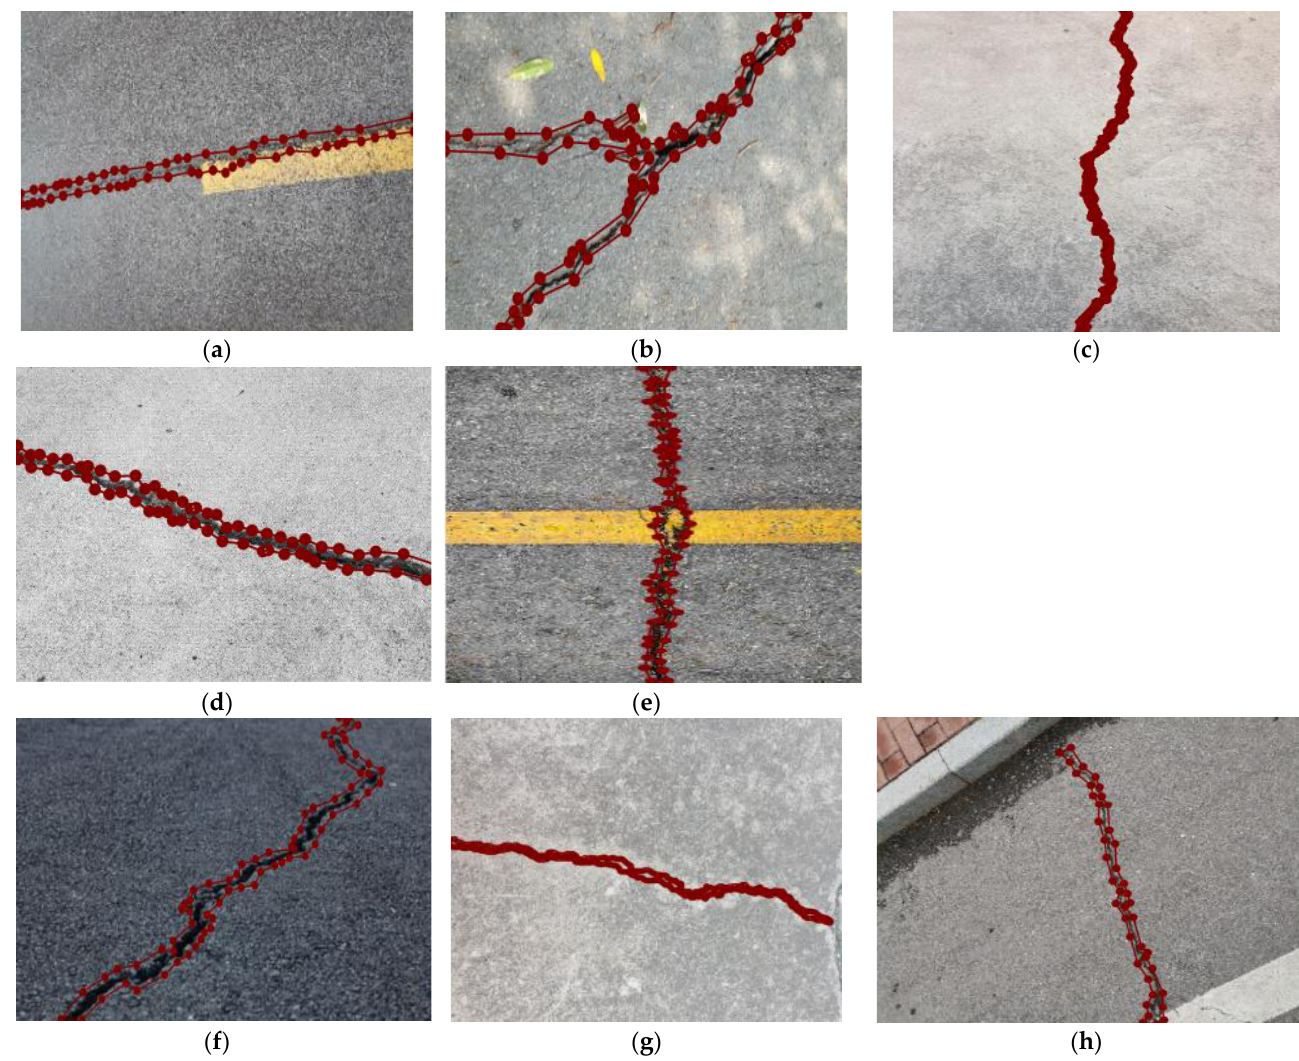
Figure 3. Part of the image data completed with labeling ( a – h